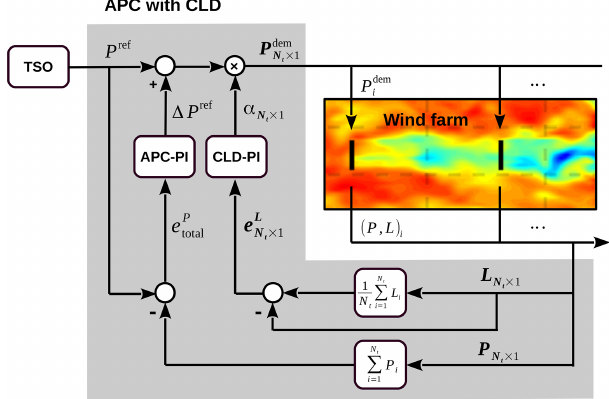
Figure 7. Schematic illustration of the proposed closed-loop APC of wind farms. The gray block depicts the main components of the wind farm control (WFC) block in Level 2 of Fig. 6. One feedback loop focuses on APC, while a second feedback loop provides coor- dinated load distribution